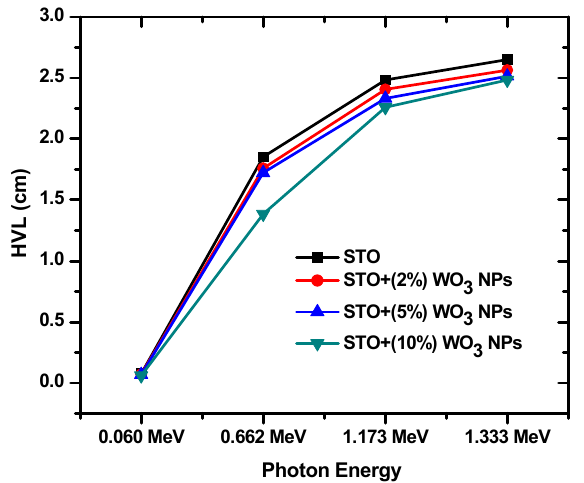
Figure 5. Half value layer of STO ceramic and STO ceramic doped with x% of WO 3 NPs. The tenth value layer (TVL) is like HVL, except it is defined as how thick a material needs to be to absorb nine-tenths of the incoming photons. Because of this, similar trends can be observed between the two figures; however, all the TVL values are higher than their HVL counterpart. The same two trends can be observed in Figure 6. Mainly, the TVL values increase with energy. For example, the TVL values for the STO with no WO 3 nanoparticles are equal to 0.247, 6.158, 8.250, and 8.809 cm at 0.060, 0.662, 1.173, and 1.333 MeV, respectively. The second trend involves the relationship between TVL and photon energy. At 0.662 MeV, the STO ceramics have TVL values of 6.158, 5.848, 5.724, and 4.604 cm for the samples with 0, 2, 5, and 10% WO 3 nanoparticles. Thus, increasing the WO 3 content in the STO ceramics improves their shielding efficiency.